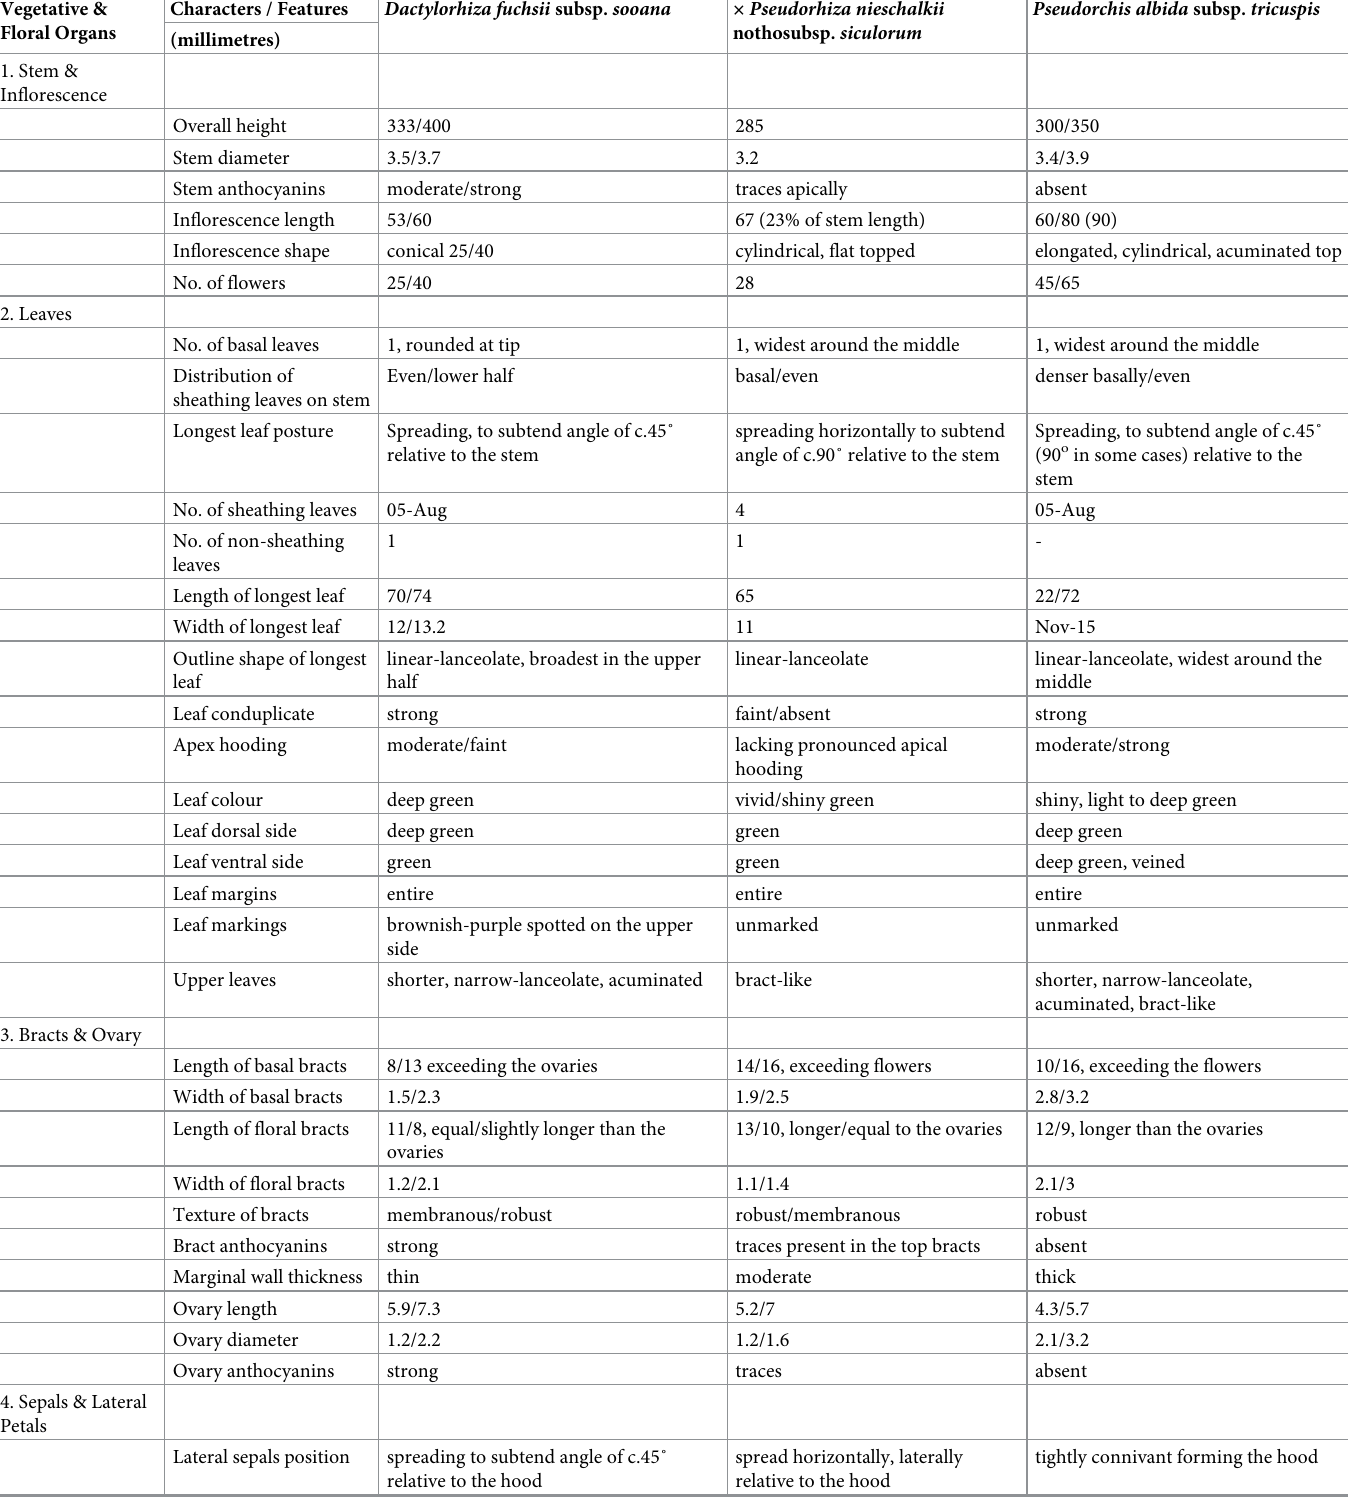
Table 1. Morphometric comparison of the putative parental species and the unique resulted hybrid. Vegetative & Floral